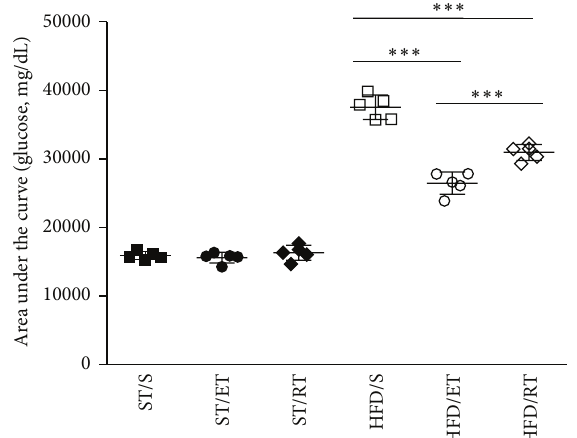
Figure 1: Area under the curve (AUC) of mean blood glucose (mg/dL) of mice fed standard chow or a high fat diet following an intraperitoneal glucose challenge. ST: standard diet, HFD: high fat diet, S: sedentary, ET: endurance training, and RT: resistance training. SD: standard deviation. For each group 𝑛 = 5 . ∗∗∗ 𝑝 < 0.001 , comparison within HFD groups: sedentary versus ET or RT and ET versus